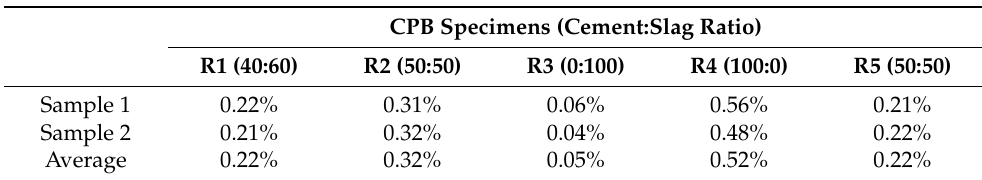
Table 7. Porosities of all CPB samples measured in X-ray computed tomography (XCT)